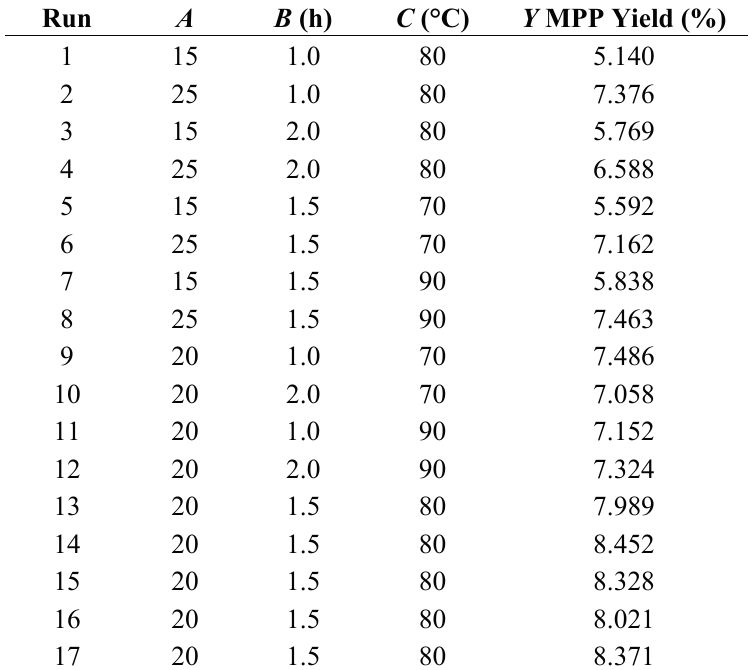
Table 1. Box-Behnken Design (BBD) experimental design with the independent variables.